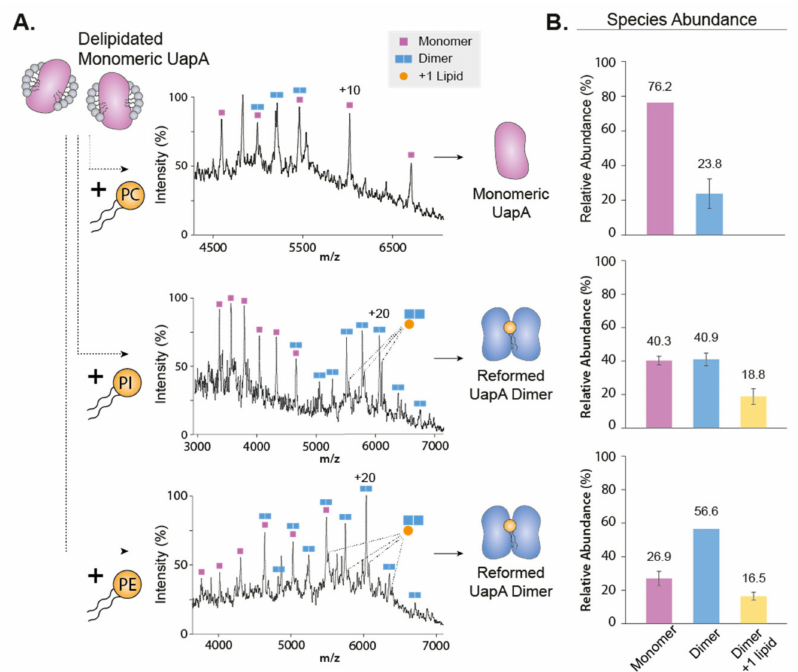
Figure 2. Addition of lipids to delipidated UapAG411V ∆ 1-11 reforms the dimer. ( A ) Mass spectra showing the effects of PC (34:1, upper), PI (34:1, middle) and PE (34:1, lower) on the oligomerization of delipidated UapAG411V ∆ 1-11 . Peaks of the lipid-bound species are highlighted. ( B ) Relative abundances of monomer and dimer species in the presence of PC (upper), PI (middle) and PE (lower) were quantified using UniDec software [56]. Adapted with permission